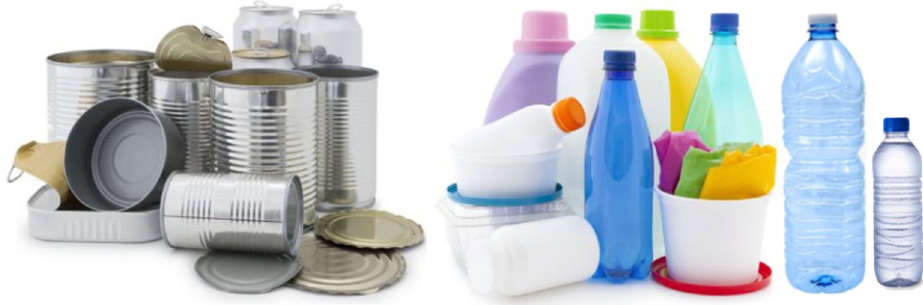
Figure 8. One of the recycling parts of household packaging: metal and plastic.